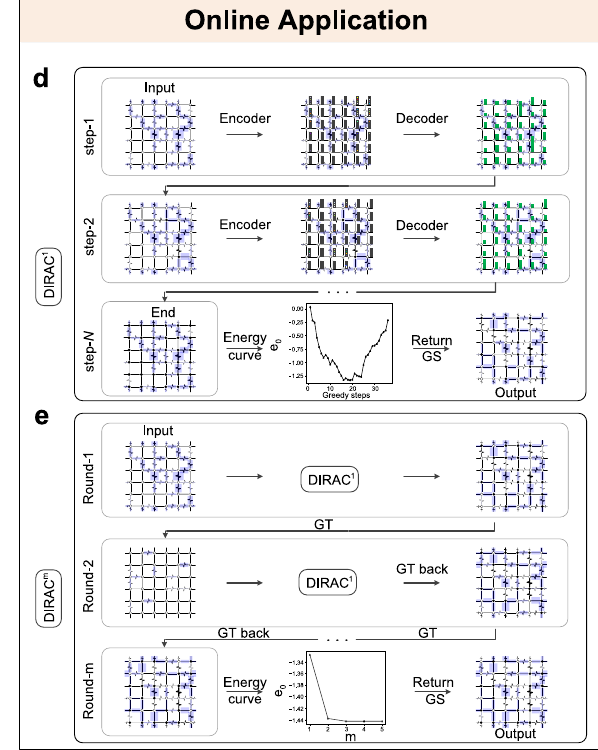
Fig. 2, DIRAC consists of two phases: of fl ine training and online application. For of fl ine training, the DIRAC agent is self-taught on randomly generated small-scale EA spin glass instances. For each instance, the agent interacts with its environment through a sequence of states, actions and rewards (Fig. 2a). Meanwhile, the agent gains experiences to update its parameters, which enhances its ability in fi nding the ground states of EA spin glasses (Fig. 2b,c). For online application, the well-trained DIRAC agent can be used either directly (DIRAC 1 , Fig. 2d) or iteratively (DIRAC m , Fig. 2e) or just as a plug-in to a thermal annealing method (DIRAC-SA and DIRAC-PT), on EA spin glass instances with much larger sizes than the training ones.